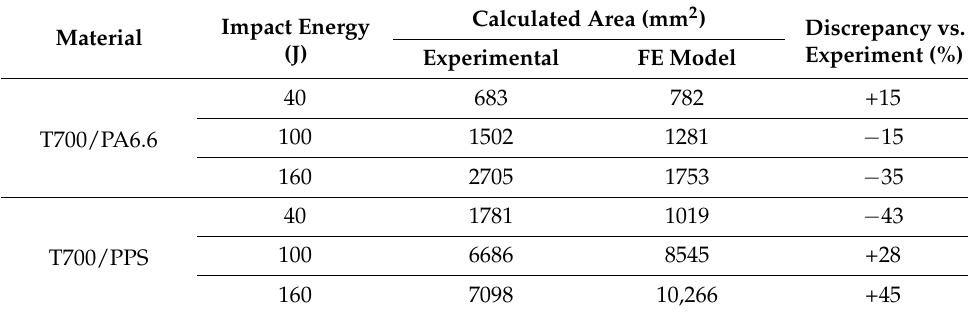
Table 9. Comparison of numerical and experimental results.